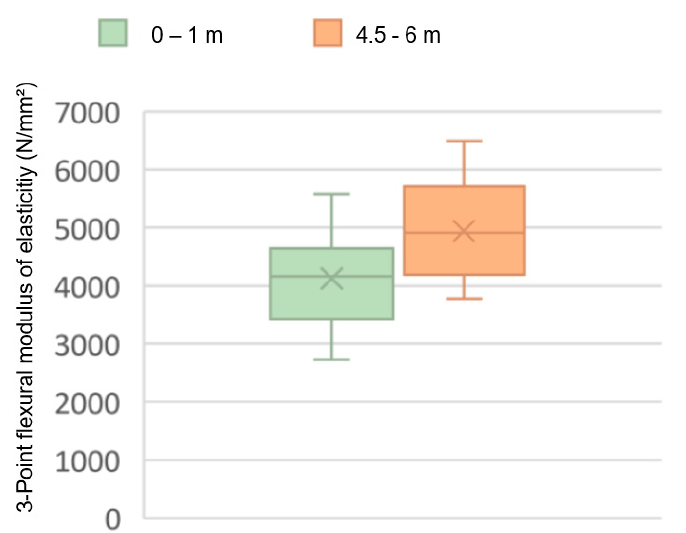
Figure 14. Modulus of elasticity of Paulownia samples extracted at 0 − 1 m and 4.5 − 6 m from the tree stem.